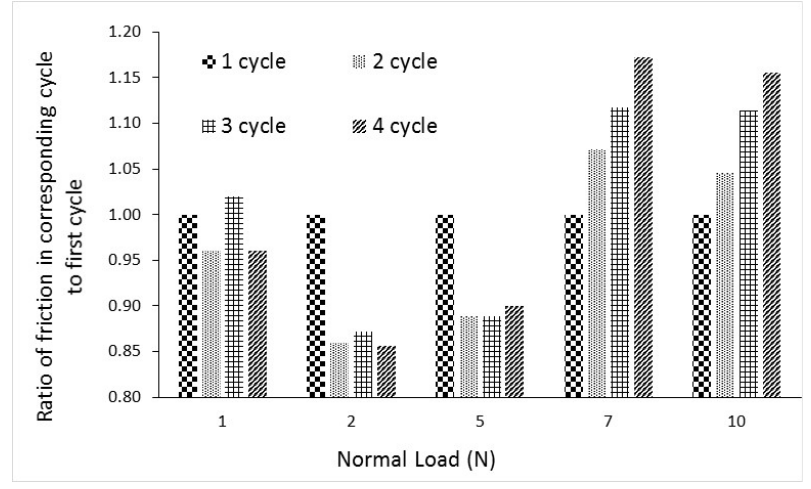
Figure 17. The effect of the shearing cycles on the inter-particle friction ratio of LBS grains.